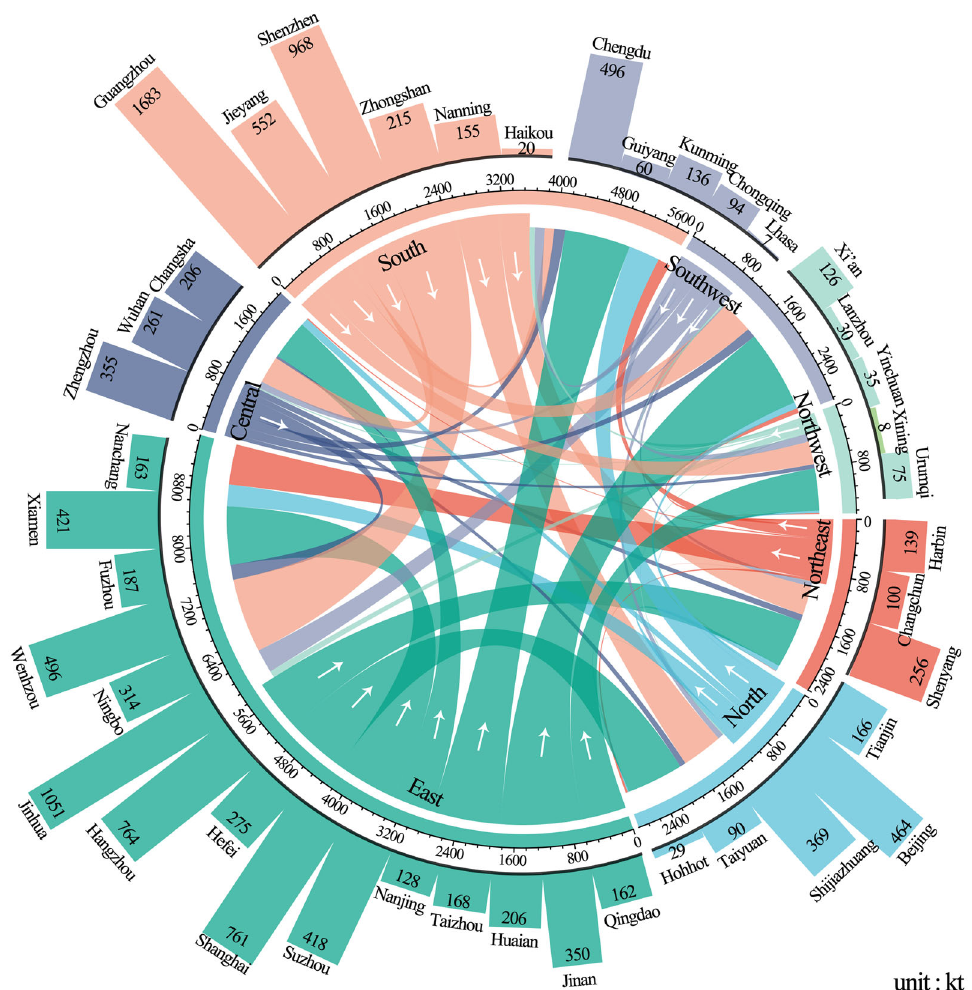
Fig. 2 Flows of GHG emissions from the logistics and transportation of intercity express deliveries among the 42 centers. (Aggregated emissions data of Phases I – V). Arrows show the direction of deliveries from origin (sender) region to destination (receiver) region. The emission amounts are attributed to the origin